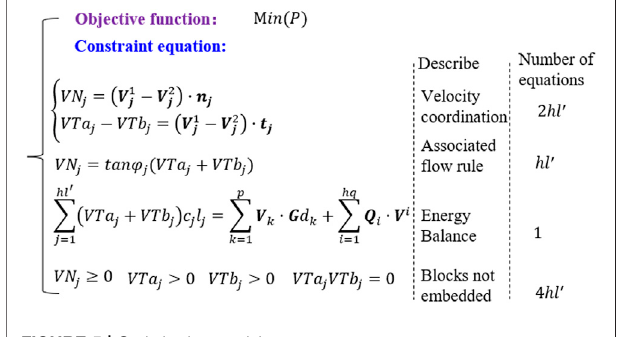
FIGURE 5 | Optimization